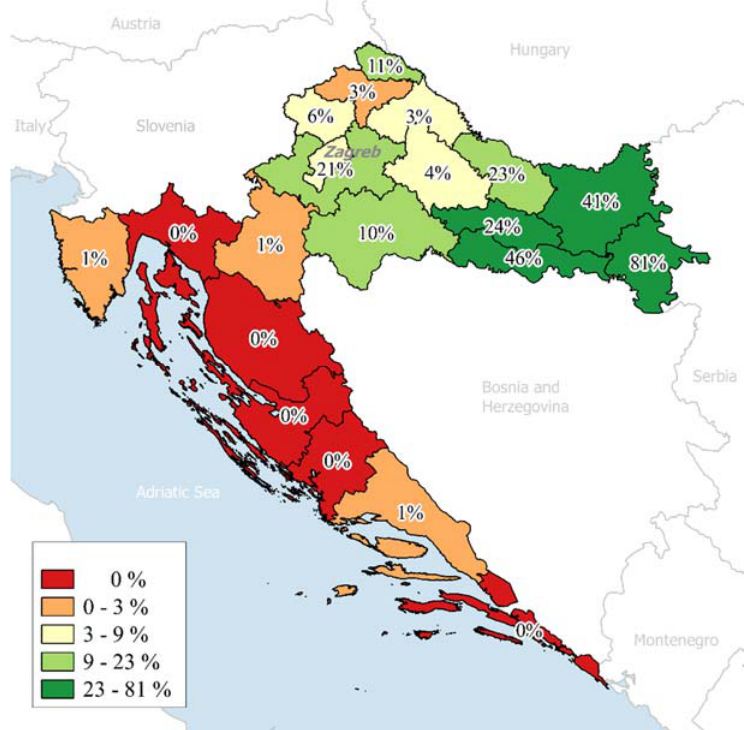
Figure 1. The percentage of land consolidated areas by counties.